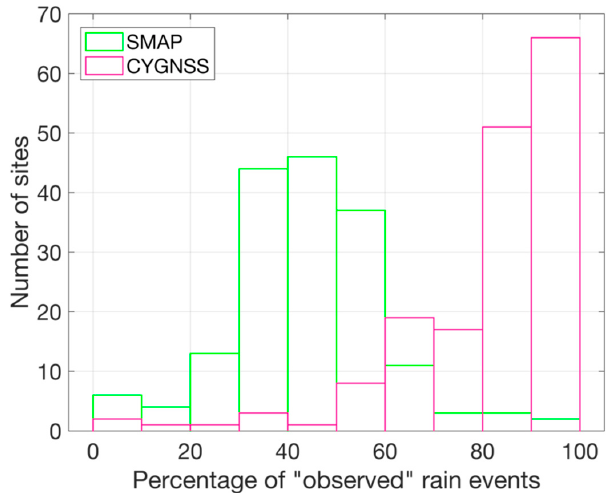
Figure 13. The percentage of rain events during the validation period observed by SMAP (green bars) and CYGNSS (pink bars). A rain event was defined as the daily averaged soil moisture value increasing by more than 0.02 cm 3 cm − 3 with respect to the previous day’s value.